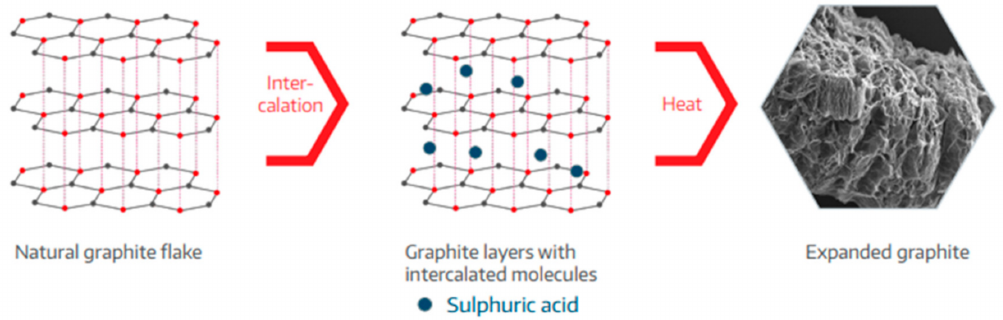
Figure 14. Intercalation of expandable graphite [34], reproduced with permission from Graphit Kropfmuehl GmbH, Hauzenberg.